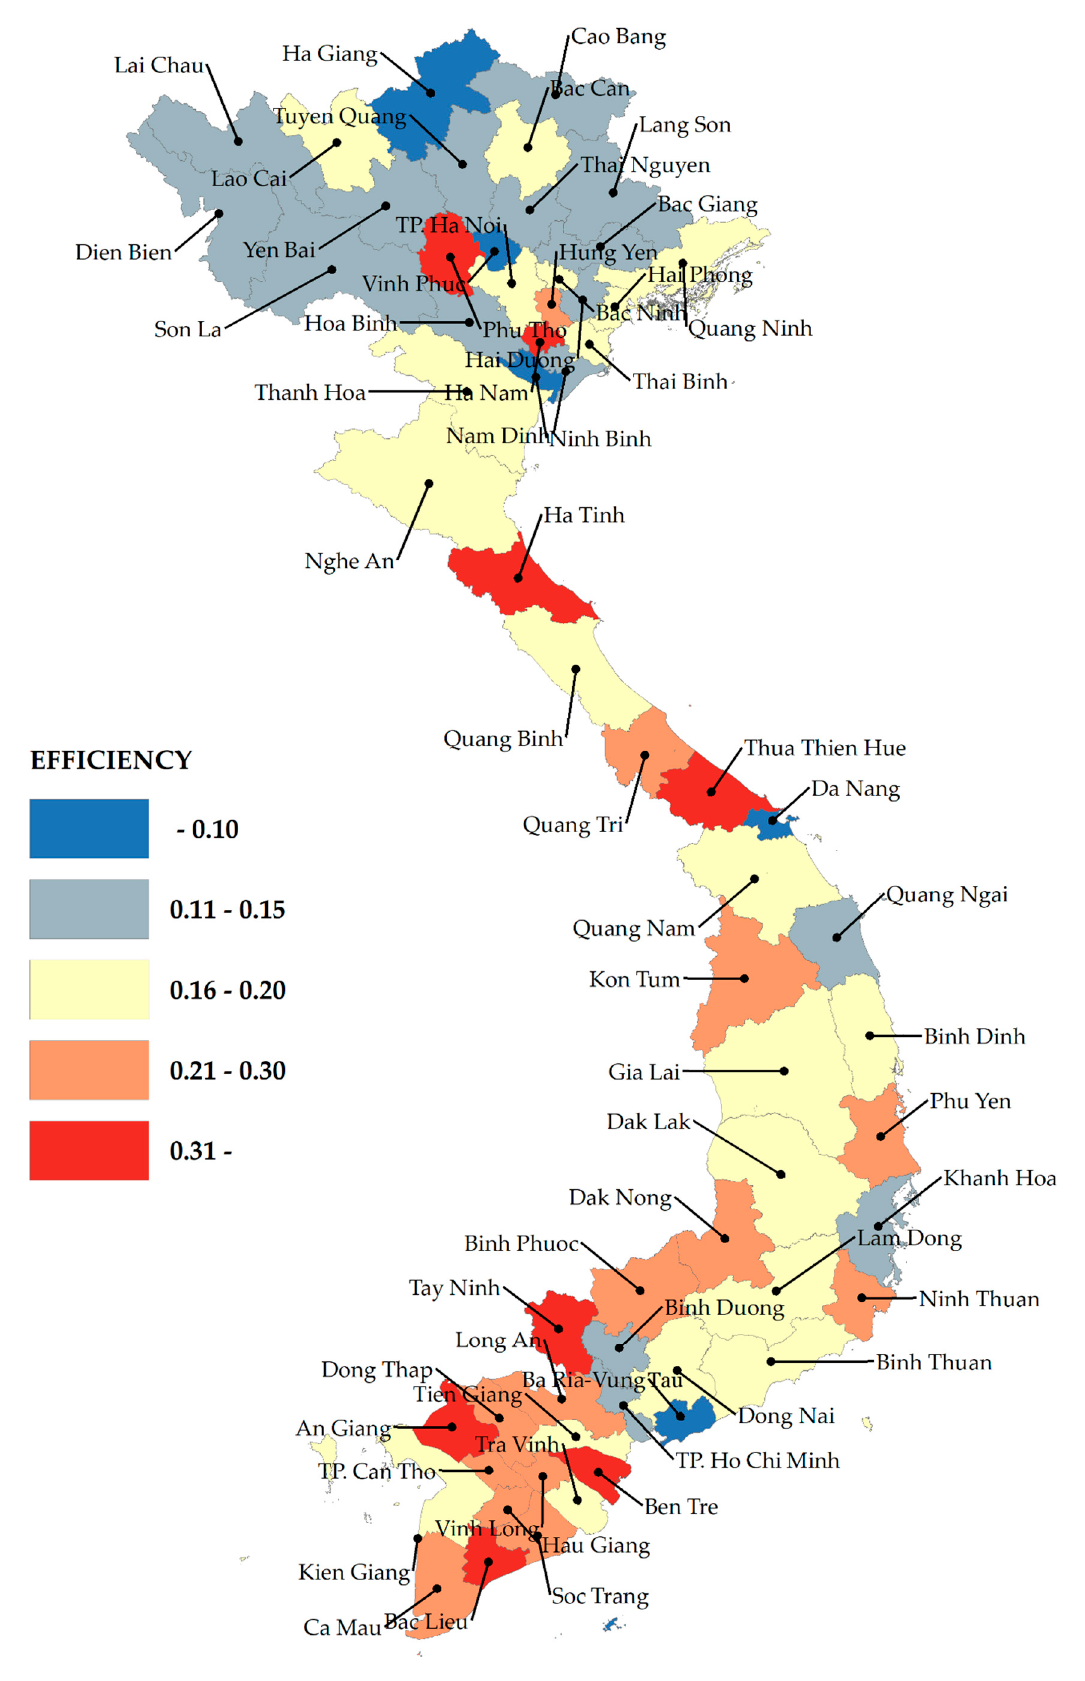
Figure 2. Map of inefficiency in Vietnam.